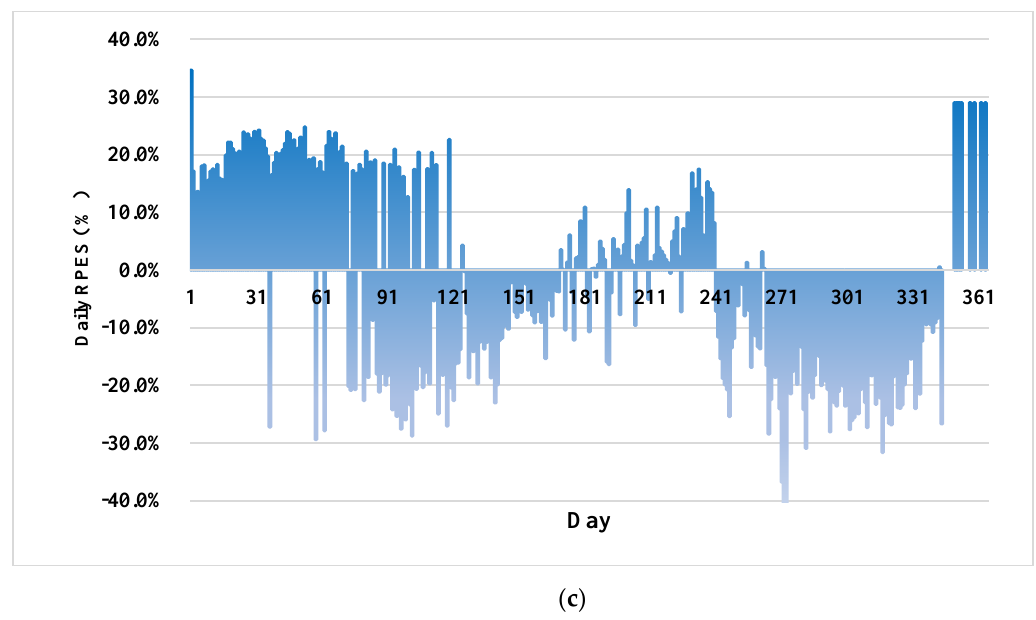
Figure 16. Profile of daily RPES during a year for the cases analyzed. ( a ) The annual daily RPES profile for Case A. ( b ) The annual daily RPES profile for Case B. ( c ) The annual daily RPES profile for Case C.